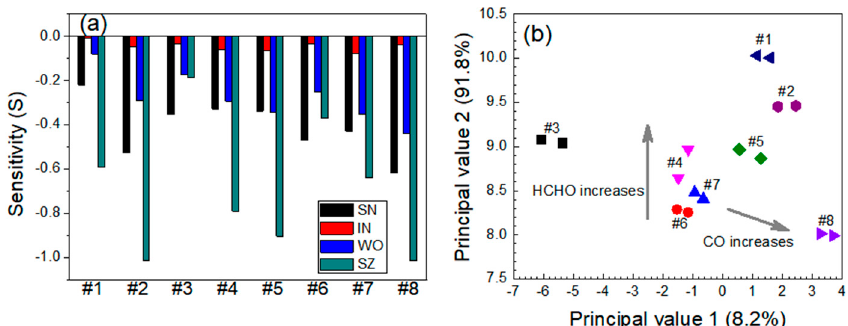
Figure 8. ( a ) Responses of the sensors and ( b ) PCA ‐ based dual ‐ gas sensor monitoring for the CO ‐ HCHO system. Note that #1–#8 represent 30 ppm CO + 0 ppm HCHO, 60 ppm CO + 0 ppm HCHO, 0 ppm CO + 2.5 ppm HCHO, 30 ppm CO + 2.5 ppm HCHO, 60 ppm CO + 2.5 ppm HCHO, 0 ppm CO + 5 ppm HCHO, 30 ppm CO + 5 ppm HCHO, and 60 ppm CO + 5 ppm HCHO, respectively.